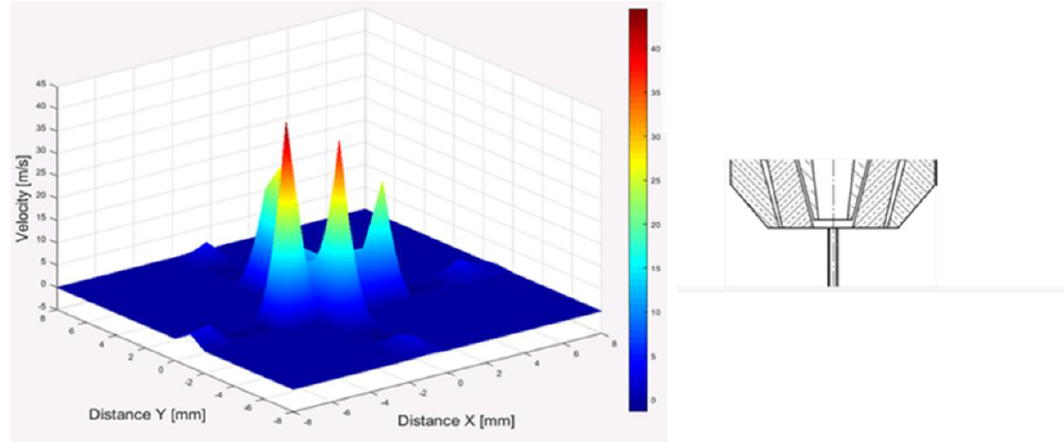
Figure 12: gas velocity measured at 0 mm from the nozzle